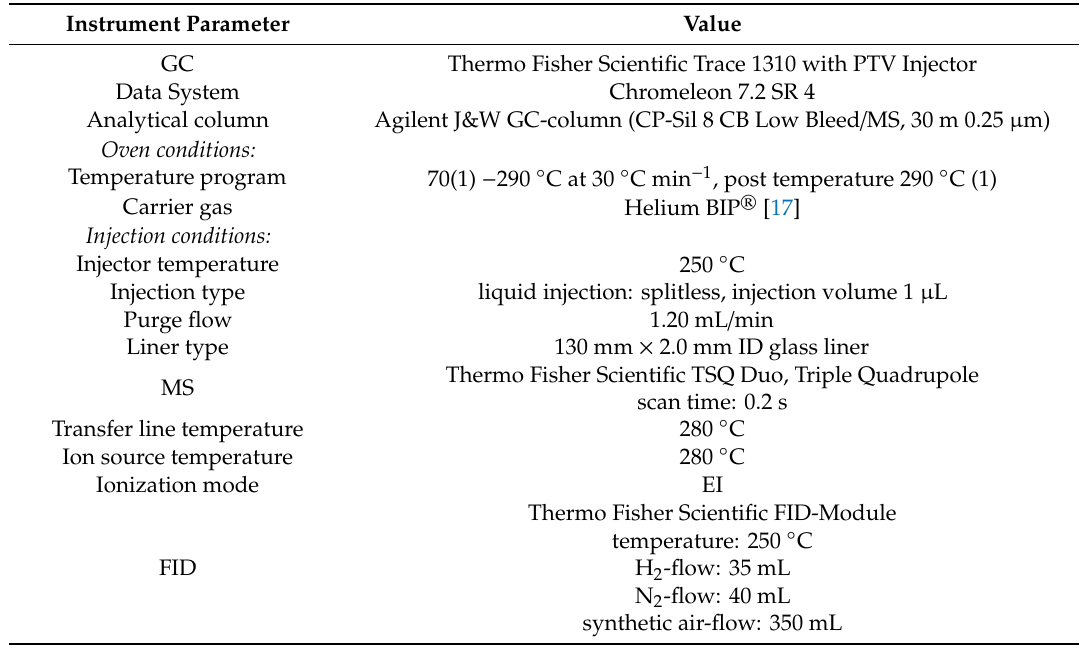
Table 1. Instrument parameters for processing of the samples on GC-FID-MS /